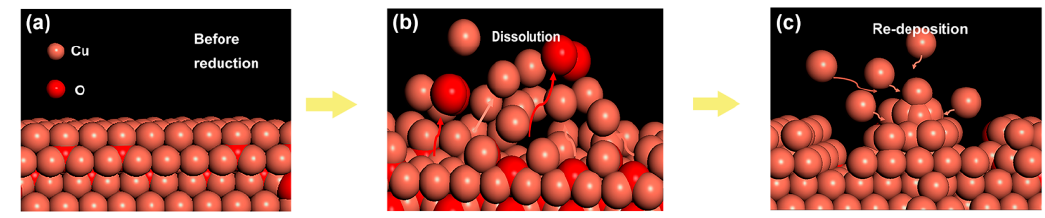
Figure 3. Schematic of reconstruction process, whereby simultaneous dissolution and redeposition occurred. ( a ) Surface morphology of the electrode before the reaction. ( b ) Dissolution of the electrode surface. ( c ) Redeposition of the electrode surface.